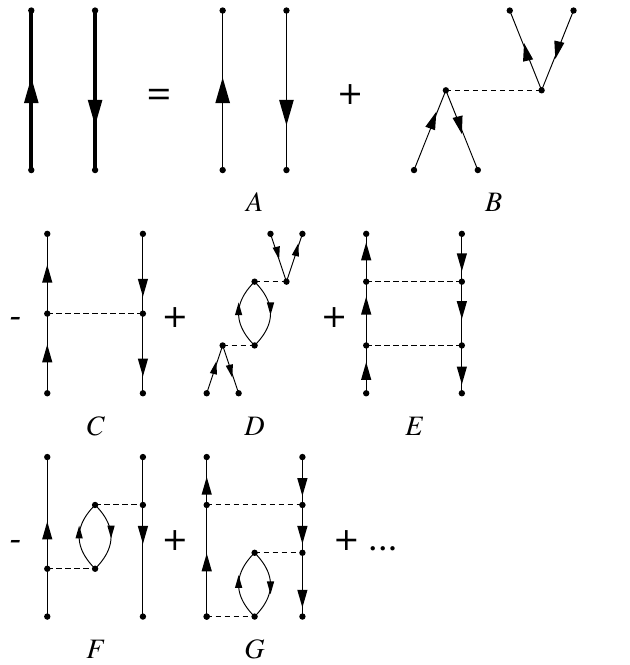
Figure 2. Graphical representation of the perturbation expansion of the interacting Green function. The double thick lines represent G, the double thin lines G 0 and the dashed lines the two-body interaction ˆ (cid:85) .